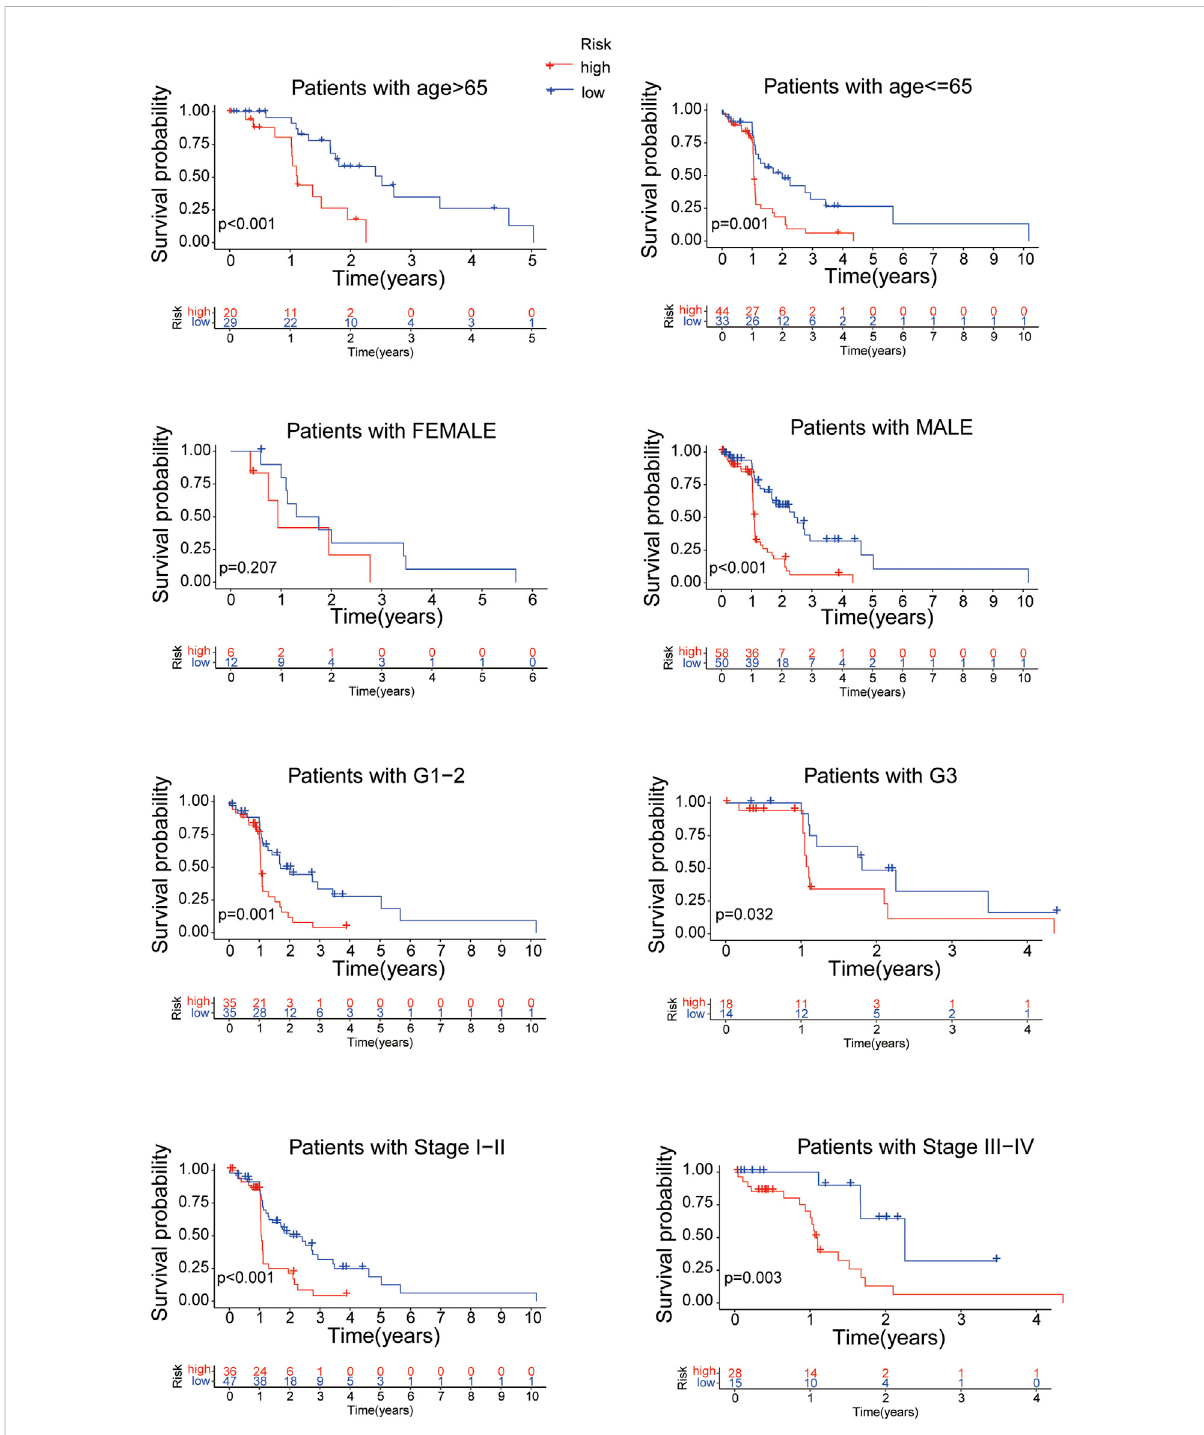
FIGURE 7 The overall survival of EC patients grouped according to clinical characteristics between the high- and low-risk